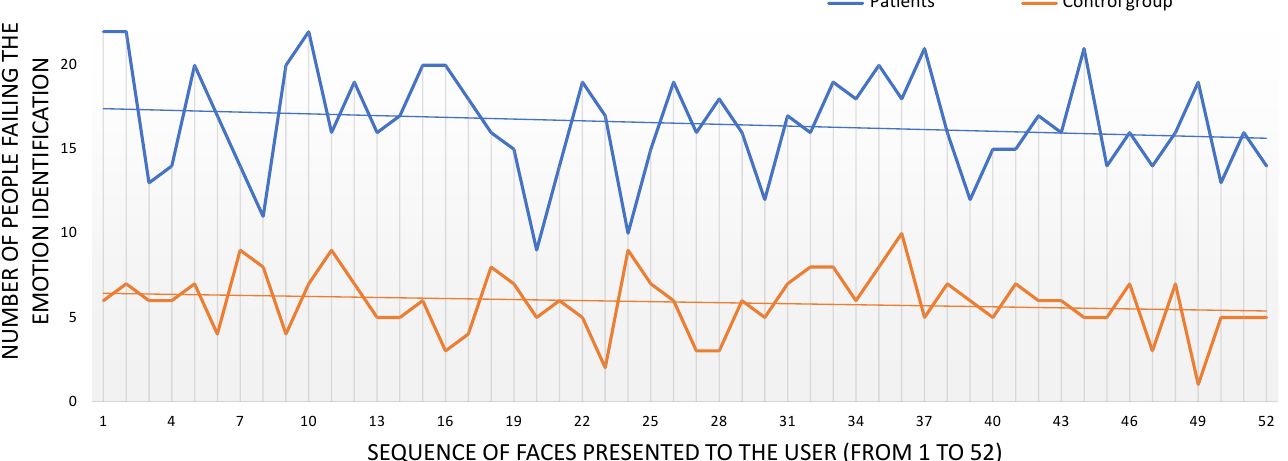
Figure 3. Emotion identification errors (y-axis). The x-axis refers to the sequence of 52 faces presented to the participants. The trend line shows a negative slope of 3.4% for the schizophrenia group and 2.1% for the control